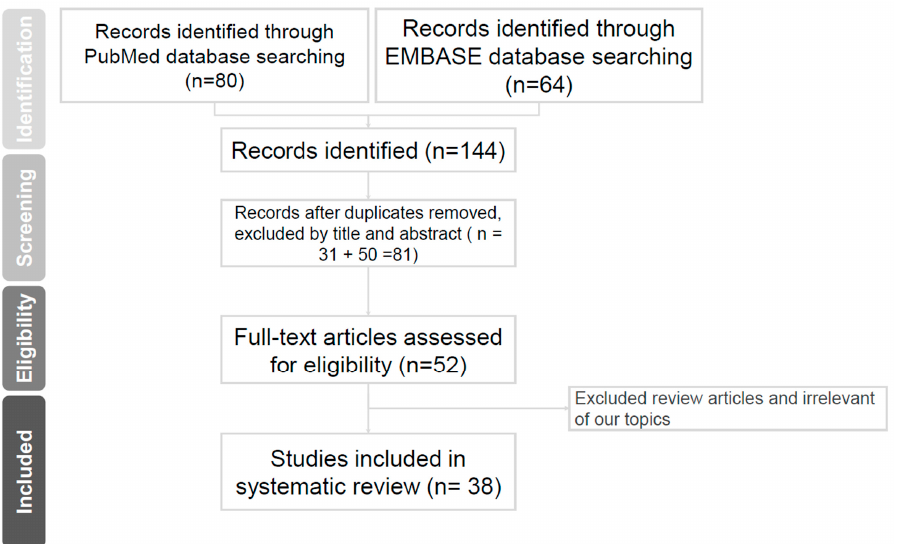
Figure 1. Evidence acquisition